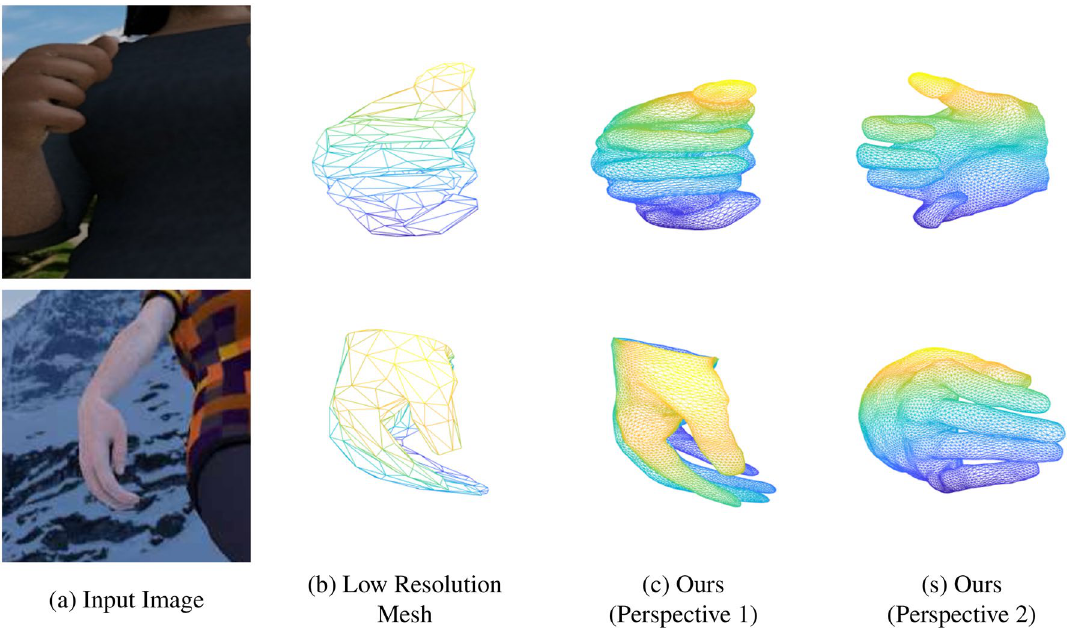
Figure 8. The qualitative results that were obtained for the model with uncoupled training data 17